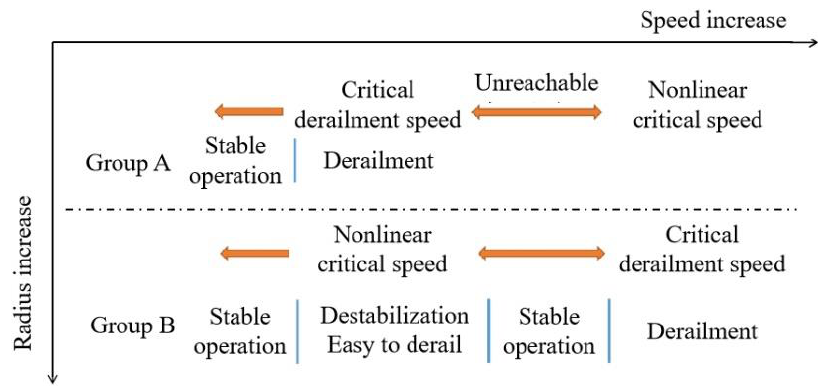
Figure 6. Running status of trains on group A and group B. Table 4. Stability conditions of the equilibrium state of the train